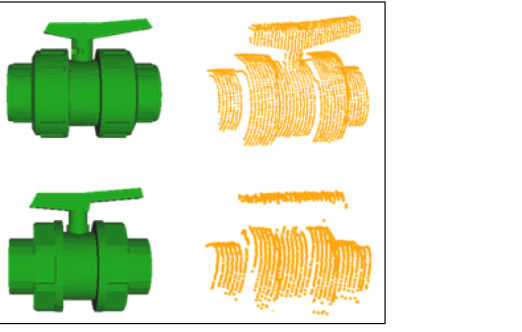
Figure 2. Ball-valve ( top ) and Ball-valve-s ( bottom ) with their respective segmented scan.